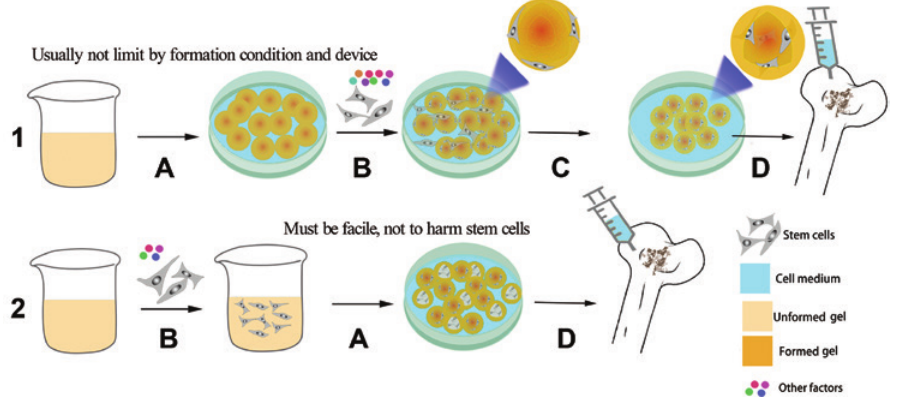
Figure 2: Fabrication course of microcarriers. 1. Formation pre-cell loading microcarriers. 2. Formation co-cell loading microcarriers. A. Formation process. B. Stem cell and other factors loading process. C. Certain time for stem cell growth and migration from the surface to inner mesh of the microcarriers. D. Injection process.